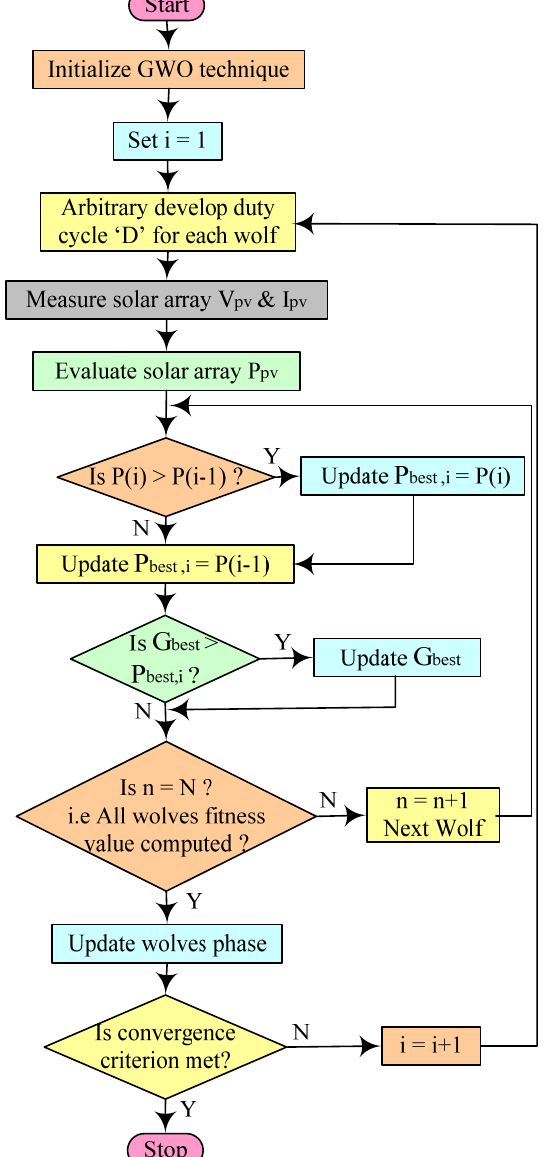
Figure 16. GWO-based MPPT technique [52].